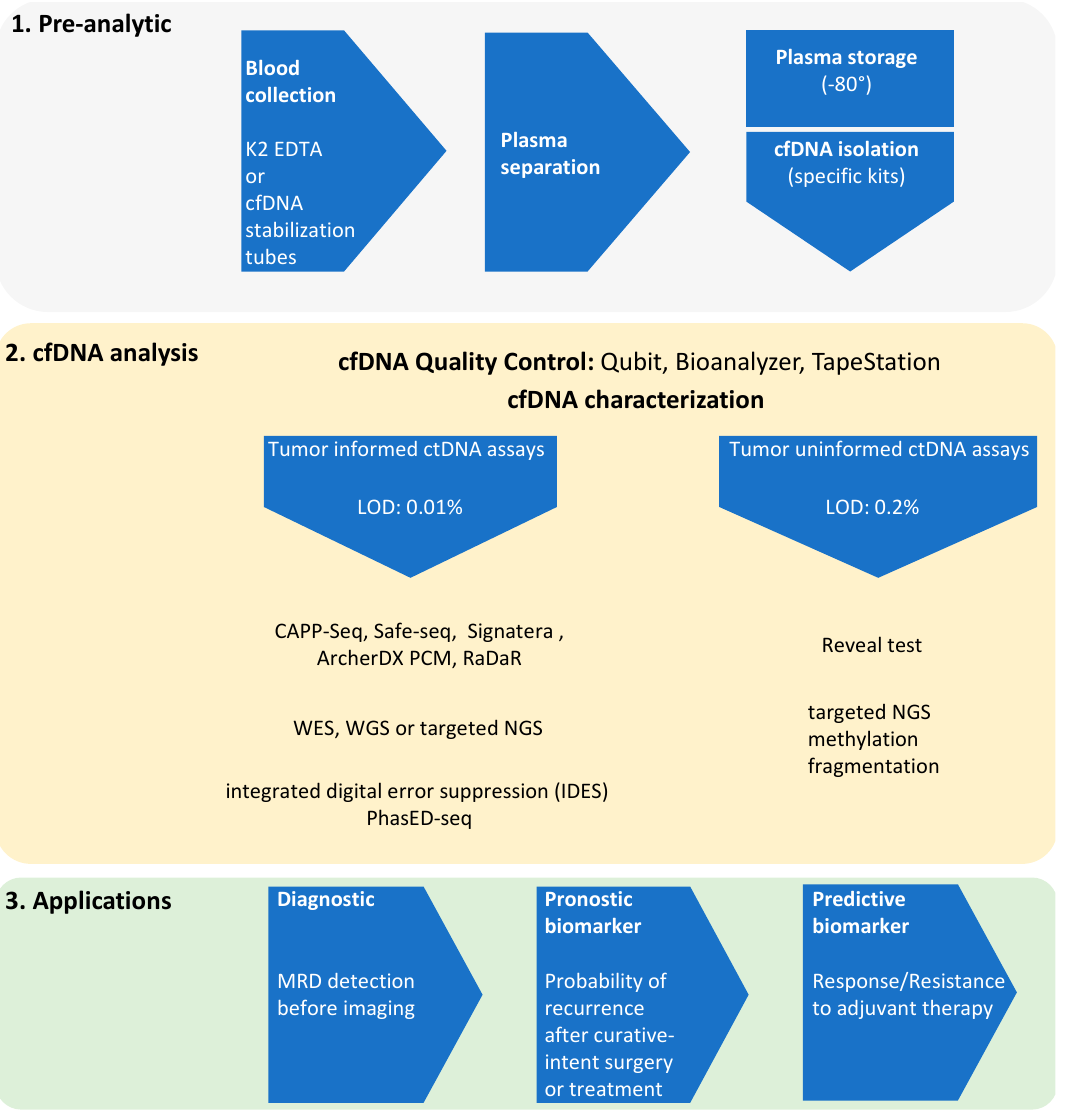
Figure 1. Workflow of ctDNA NGS in the settings of minimal residual disease (MRD). Table 1. List of the main NGS-based assays used to assess potential presence of MRD in the blood.